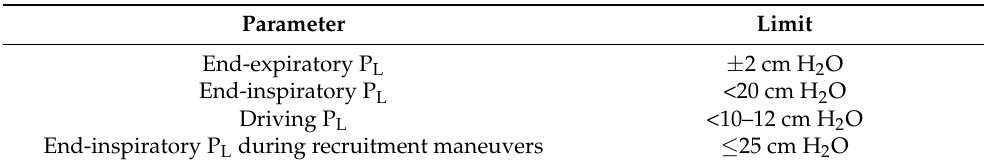
Table 3. Suggested limits of transpulmonary pressures in patients with ARDS. Adapted from Mauri et al. [1], Bayerdorf Kassis at al. [15], and Pelosi et al. [28]. Parameter Limit End-expiratory P